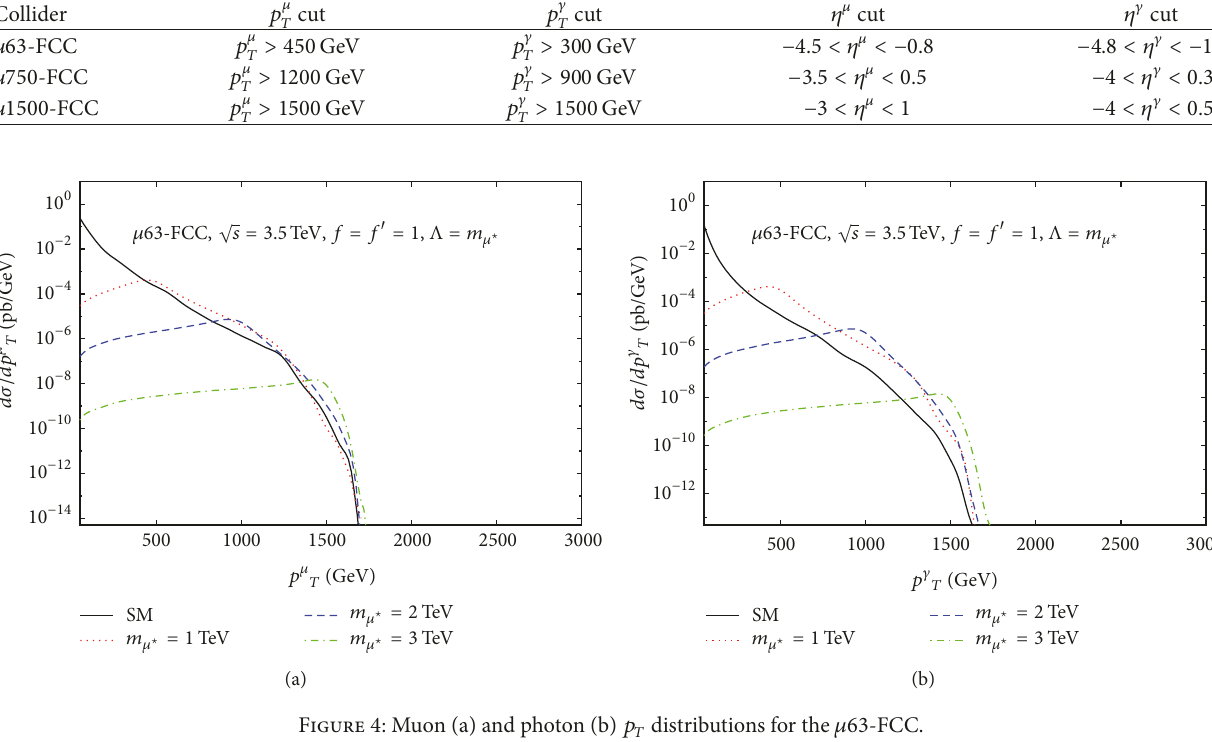
Figure 4: Muon (a) and photon (b) 𝑝 𝑇 distributions for the 𝜇63 -FCC.